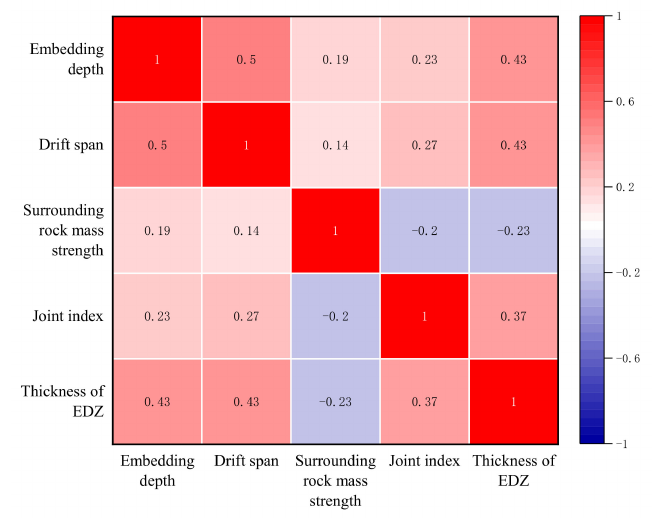
Figure 3. The correlation heat map of each indicator.